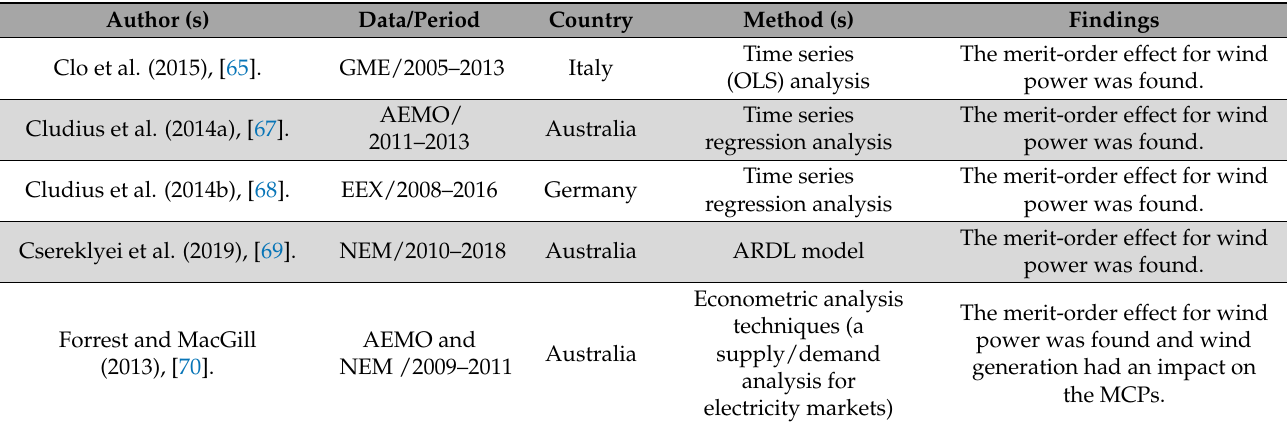
Table 2. Statistical models (first-part) on electricity market price and load forecasting through wind energy. Author (s) Data/Period Country Method (s) Findings